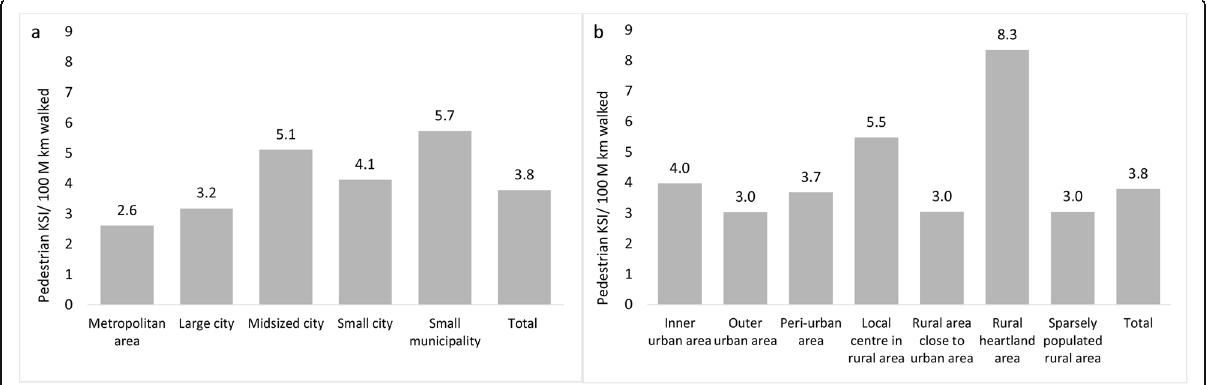
Fig. 3 Pedestrian KSI rate according to ( a ) type of municipality and ( b ) area type